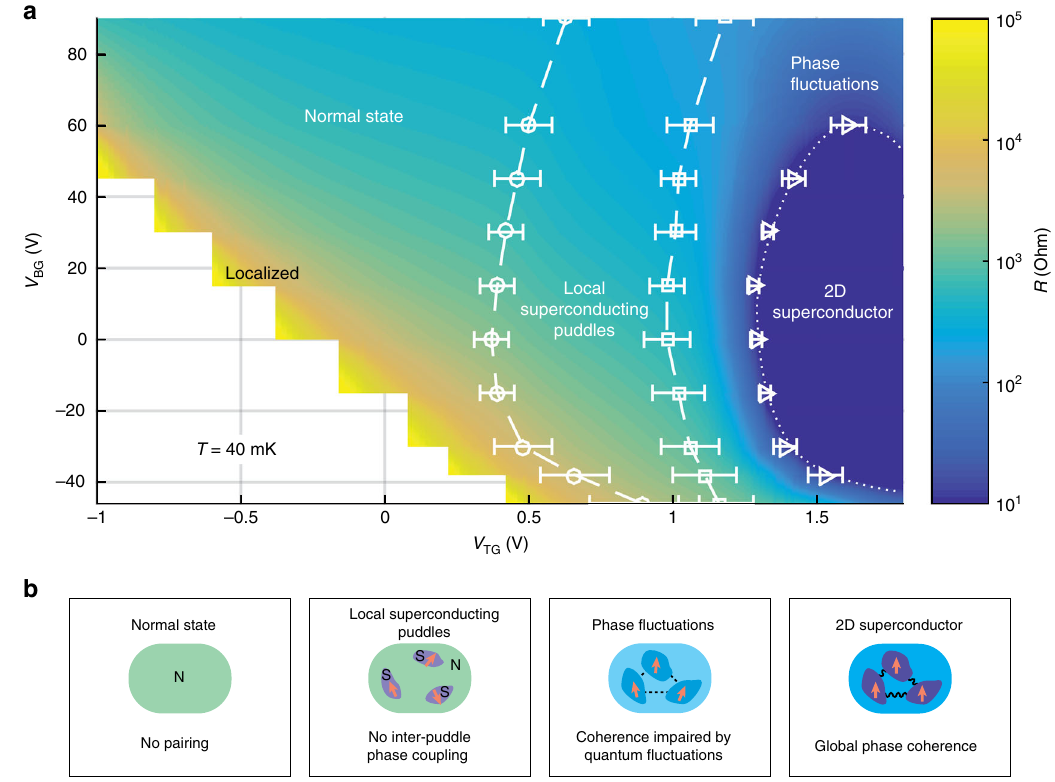
Fig. 4 Ground-state phase diagram by dual gates. a Sheet resistivity mapping as a function of V TG and V BG measured at T = 40 mK. The colour scale is based on interpolated resistivity. Circles and squares are extracted from the peaks of the second-order derivative calculated using a spline fi t of the resistivity-versus- V TG curves. Error bars are de fi ned by the full width of the second derivative peaks. Triangles are the gate voltages at which the resistivity drops to 1% of normal-state resistance. The circles, squares, and triangles indicate the voltages where T P , T F , and T C extrapolate to zero temperature, respectively. The dotted line represents a superconductor – metal phase transition line. Normal state here indicates a non-superconducting state. b Schematics of the four different ground states in the phase diagram. The red arrows represent the superconducting phase of individual puddles. N normal state, S superconducting